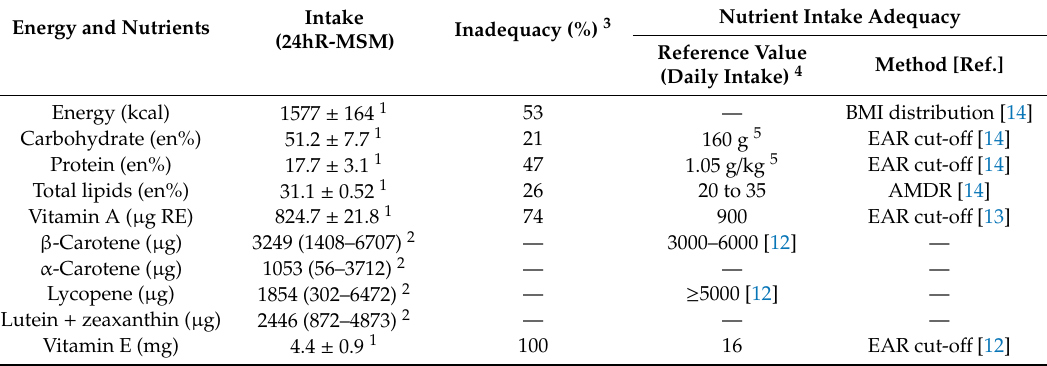
Table 2. Intake of energy and nutrients by Brazilian nursing women from the 2nd to the 14th week of lactation.